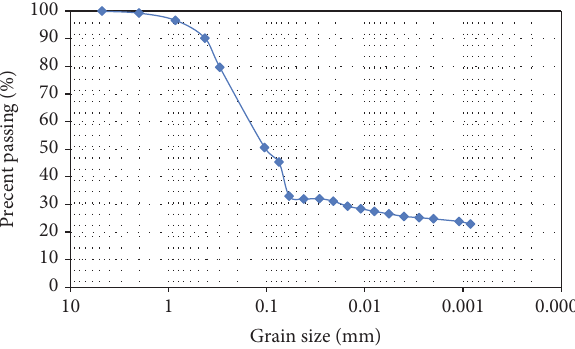
Figure 1: Grain size distributions for UKM soil.